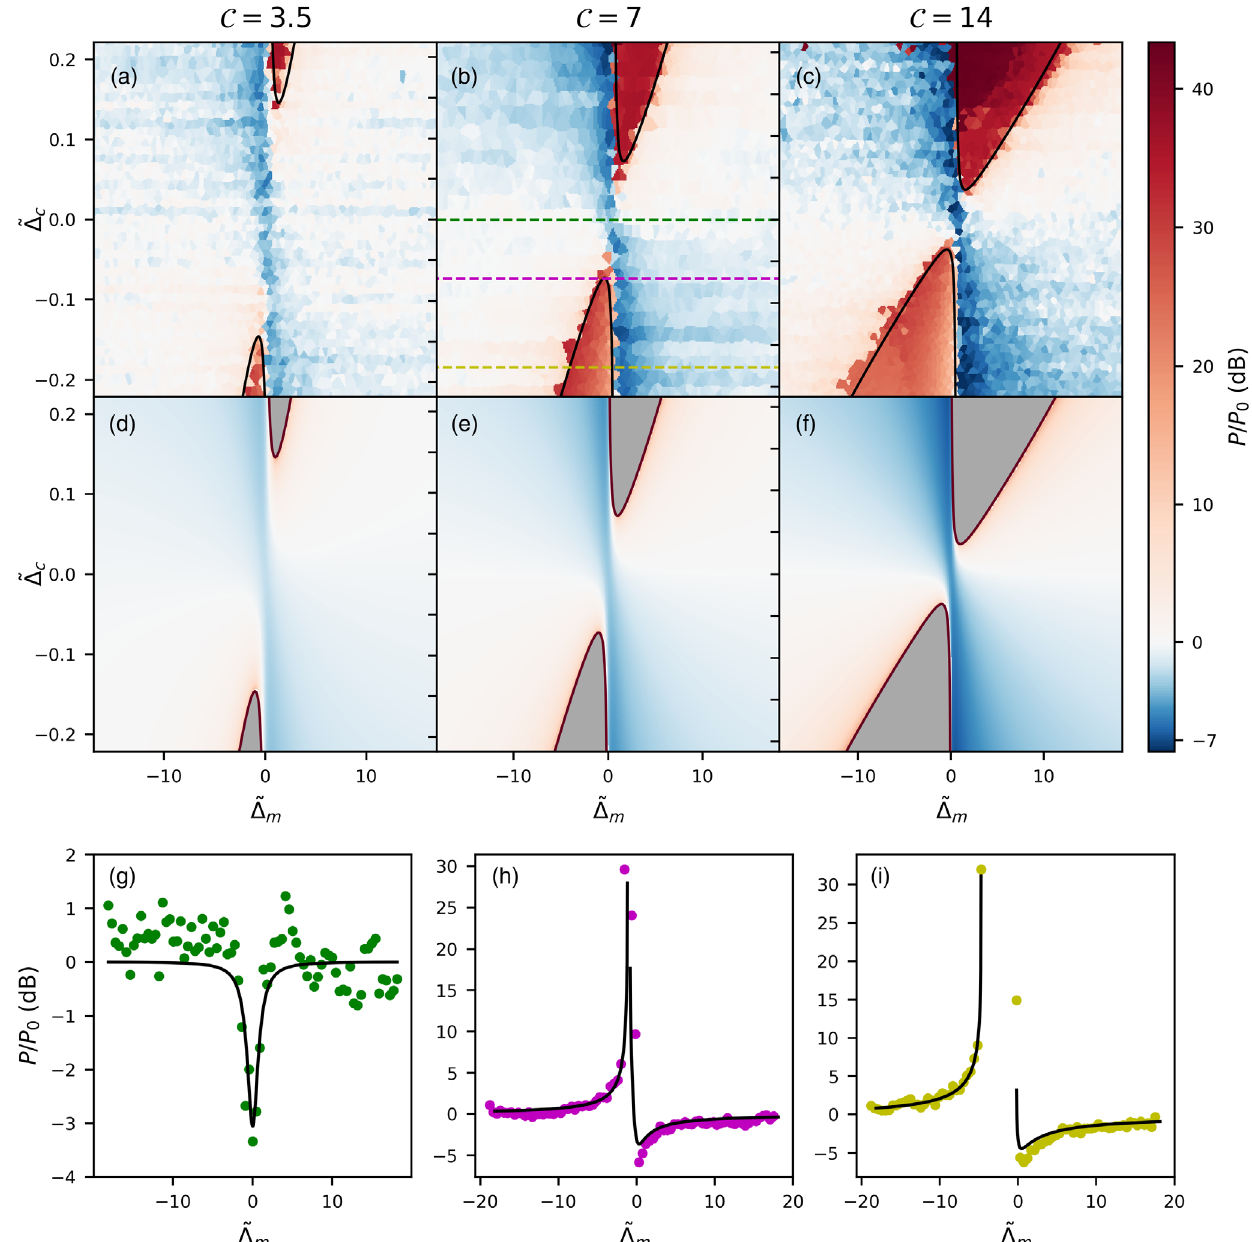
FIG. 4. Investigation of the two-tone instability in a circuit-electromechanical system. (a) – (c) Mapping of the total mechanical noise as ˜ Δ ˜ Δ a function of and , for cooperativities C ¼ f 3 . 5 ; 7 ; 14 g , respectively. The total power P in both mechanical sidebands in the output m c ˜ Δ ˜ Δ − 18 ; 0 Þ (no tuning error and far from the BAE regime). Since data points ; spectra is shown, normalized to the power P 0 at ð m c Þ ¼ ð ˜ Δ do not align on a regular grid (accounting for small changes in along the horizontal scan), the rasterization was implemented using c nearest-neighbor (Voronoi) partitioning. Solid black lines are instability thresholds from Eq. (6). (d) – (f) Theory plots corresponding to ˜ Δ 0 ; − 0 . 07 ; − 0 . 18 g , respectively (a) – (c). Gray areas are unstable regions predicted by theory. (g) – (i) Cross sections of (b) for c ¼ f [nearest data points to horizontal dashed lines in (b)]. Solid black lines are theory predictions based on the full linear